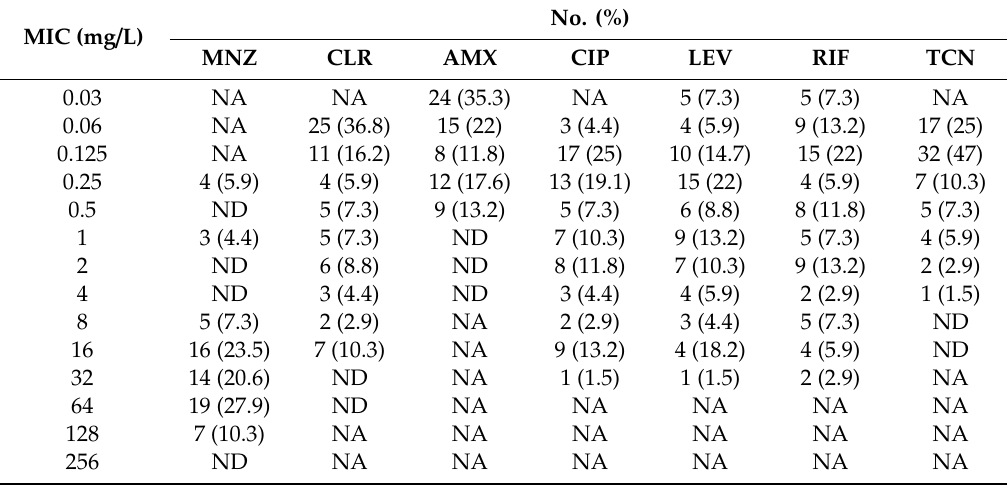
Table 3. Distribution of MIC values for each antibiotic among H. pylori isolates used in this study. MIC (mg /